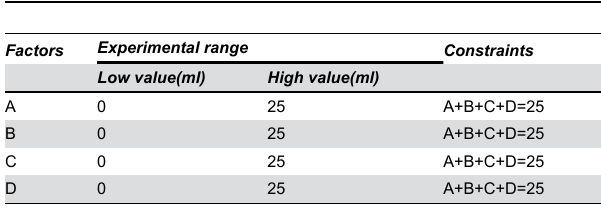
Table 1. Experimental ranges for independent variables and constraints.